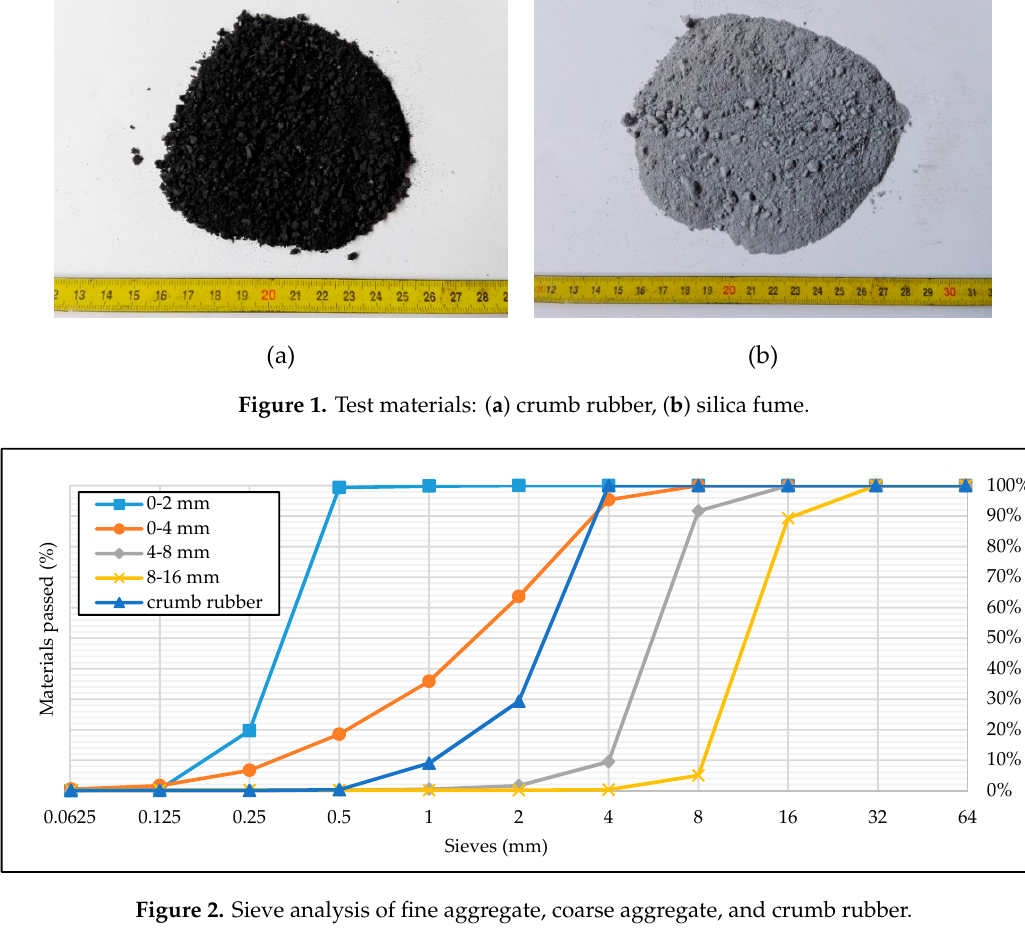
Table 4. Mix proportions for self-compacting concrete (kg/m 3 ). CA: coarse aggregate, CR: crumb